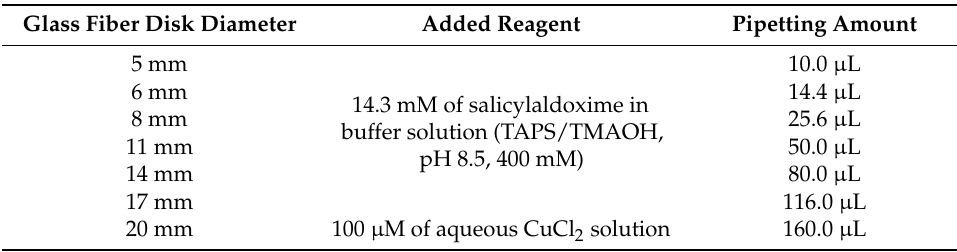
Table 1. Summary of reagents added onto the glass fiber